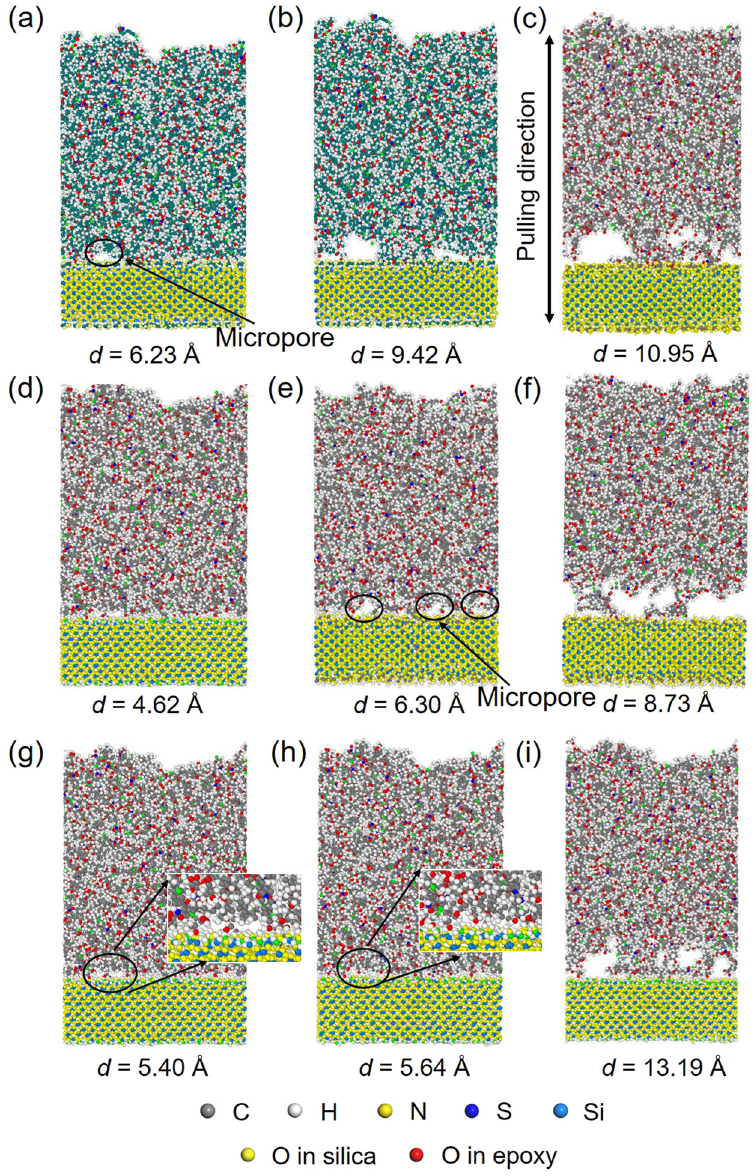
Figure 9: The structural evaluation of the interface in di ff erent systems. For the system with formyl groups, ( a ) the formation of micropores; ( b ) the growth of micropores; and ( c ) the failed interfacial structures at the point of PMF ( d ) the peak . For the system with carboxyl groups, formation of micropores; ( e ) the generation and growth of multi micropores; and ( f ) the failed interfacial structures at the point of PMF peak . For the system with amine groups, ( g ) the formation of micropores; ( h ) the reduction in micropore size; and ( i ) the failed interfacial structures with a great number of polymer chains in epoxy still bonded to